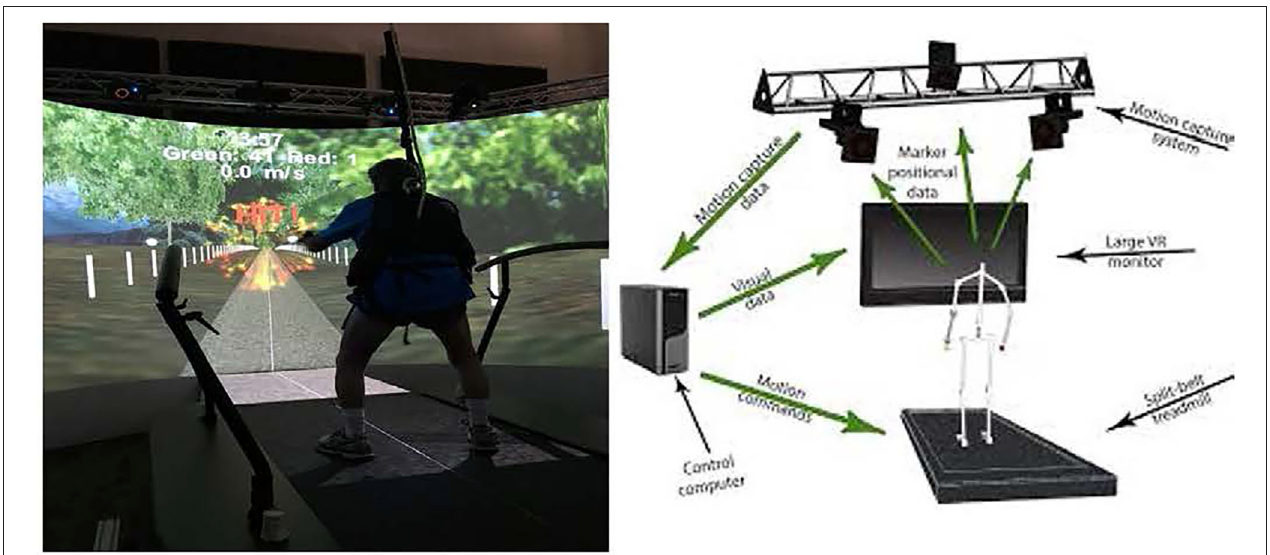
Frontiers in Sports and Active Living |